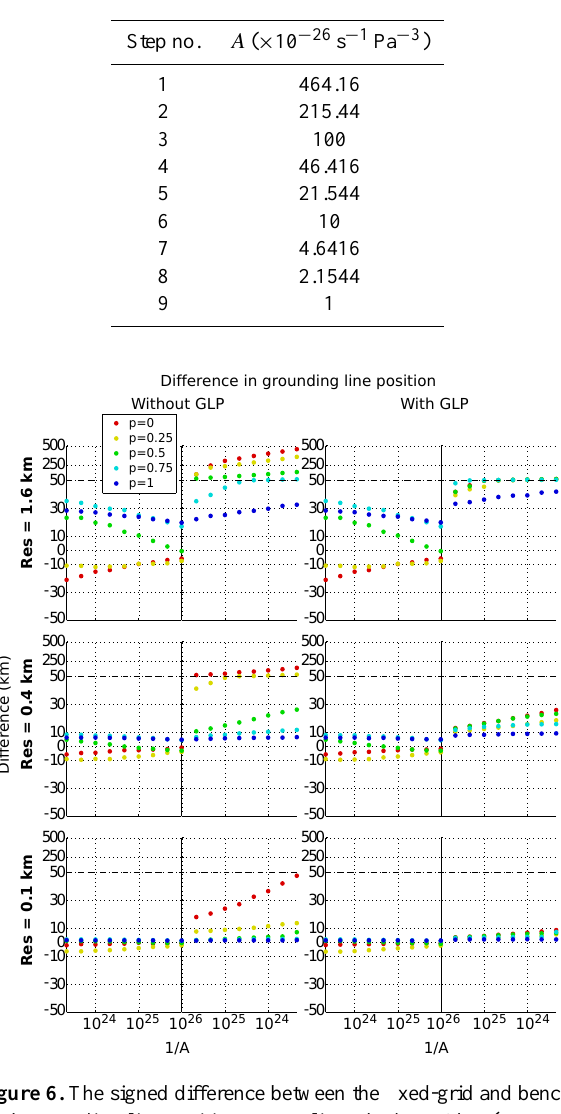
Table 3. Values of the ice softness A used in the MISMIP experi- ment 1 (linear bed). These are the same values prescribed in Pattyn et al. (2012).